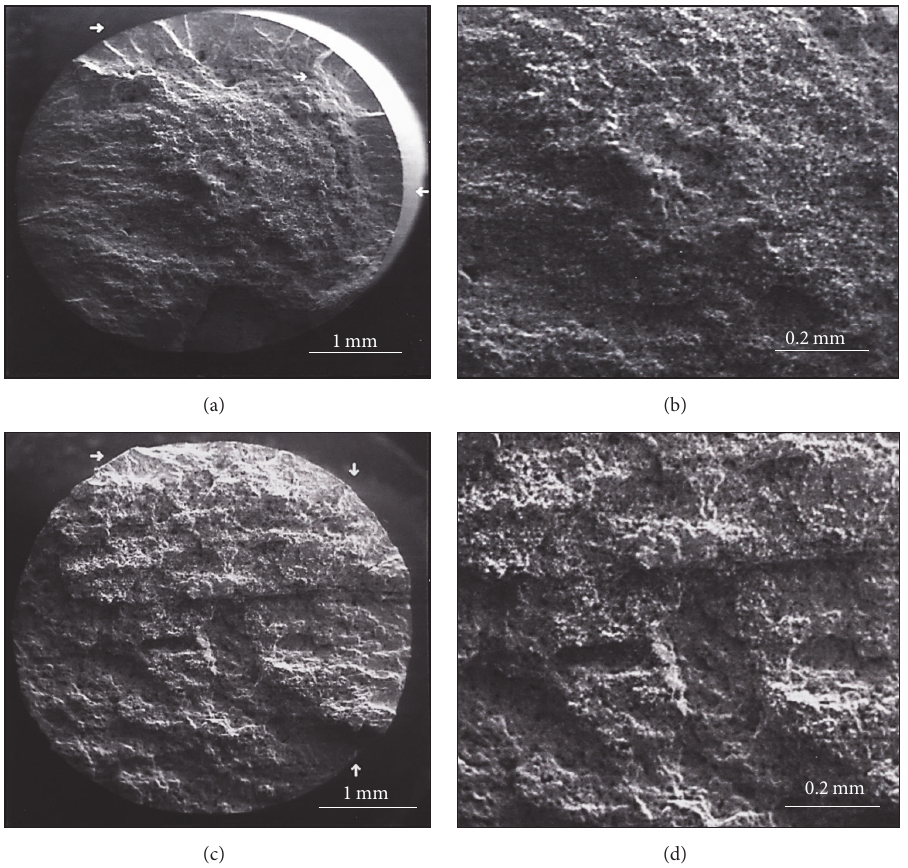
Figure 14: Fracture surface of fatigue DCM5 samples following aging at (a and b) 155 ∘ C for 20 h and (c and d) 220 ∘ C for 25 h. The white arrows in (a) and (c) refer to crack initiation sites.